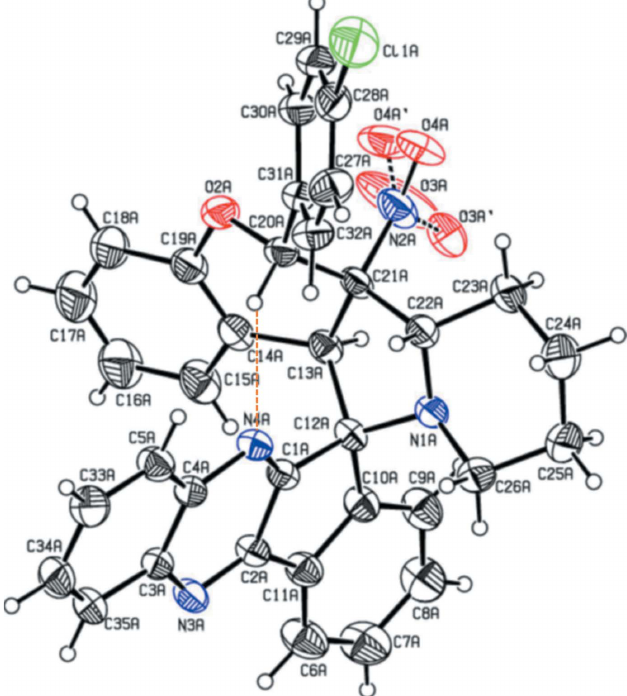
Figure 1 View of the molecular structure of molecule A of the title compound, with the atom labelling. Displacement ellipsoids are drawn at the 30% probability level. The intramolecular C—H (cid:2)(cid:2)(cid:2) N contact (Table 1) is shown as an orange dashed line.